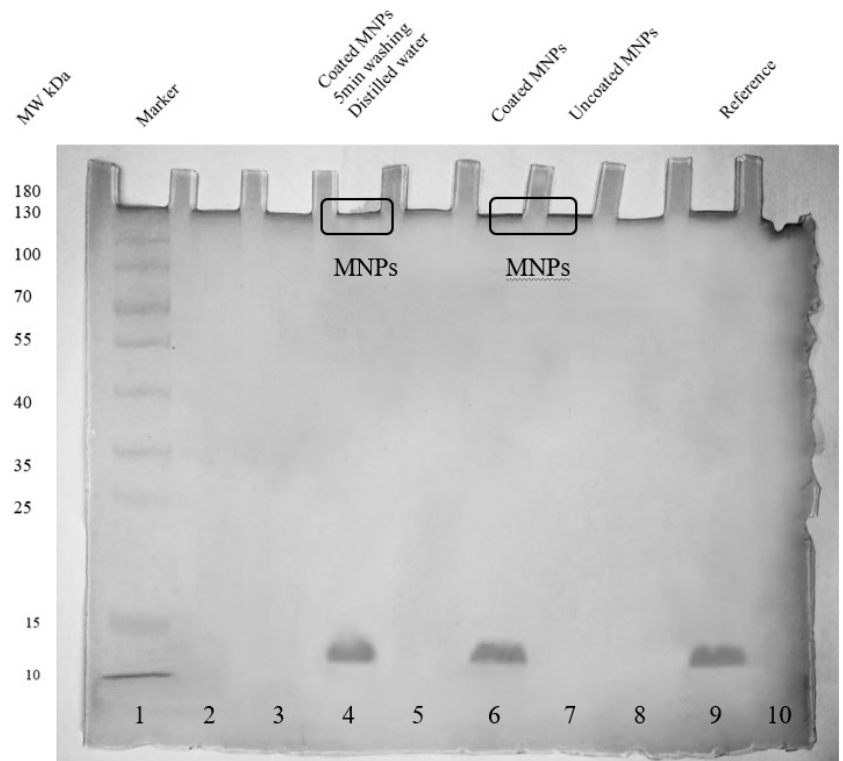
Figure 7. SDS PAGE (15% silver-stained uncropped gel) analysis of the presence of blood plasma proteins on conjugates. Lane 4 shows no presence of blood plasma proteins on conjugates. Conjugates of magnetite nanoparticles-hemoglobin and uncoated magnetite nanoparticles were taken as control, as shown in lanes 6 and 7, respectively. Lane 9 shows reference hemoglobin molecules. The color image of uncropped gel is shown in Appendix A Figure